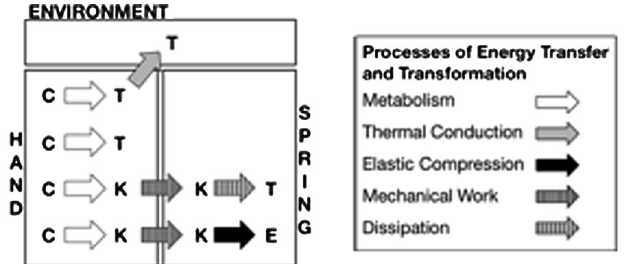
FIG. 4. Energy Tracking Diagram for a hand compressing a spring at constant speed. C, K, T, and E represent chemical, kinetic, thermal, and elastic energy, respectively. White, gray, black, striped, and hatched arrows represent metabolism, thermal conduction, elastic compression, mechanical work, and dissipa- tion,